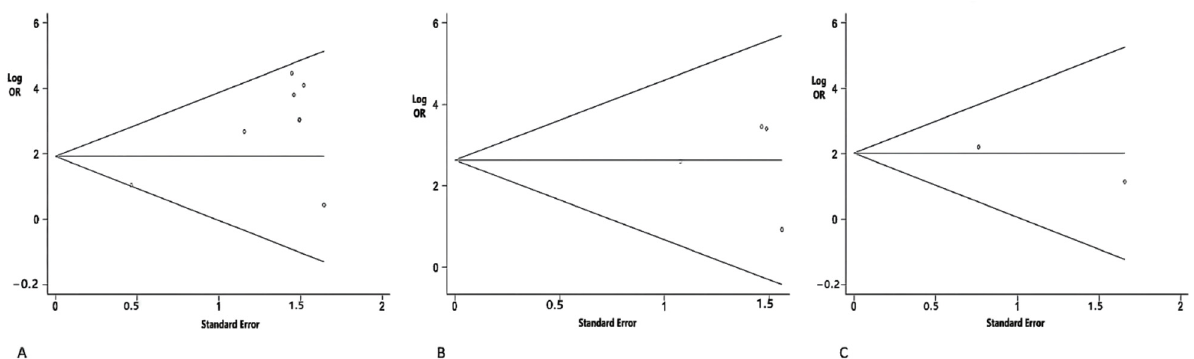
Figure 3. Funnel plot analysis used to detect publication bias: ( A ) the absence rate of cVEMP ( p = 0.621 in Begg’s test); ( B ) the absence rate of oVEMP ( p = 0.497 in Begg’s test); ( C ) the absence rate of mVEMP ( p = 0.317 in Begg’s test).